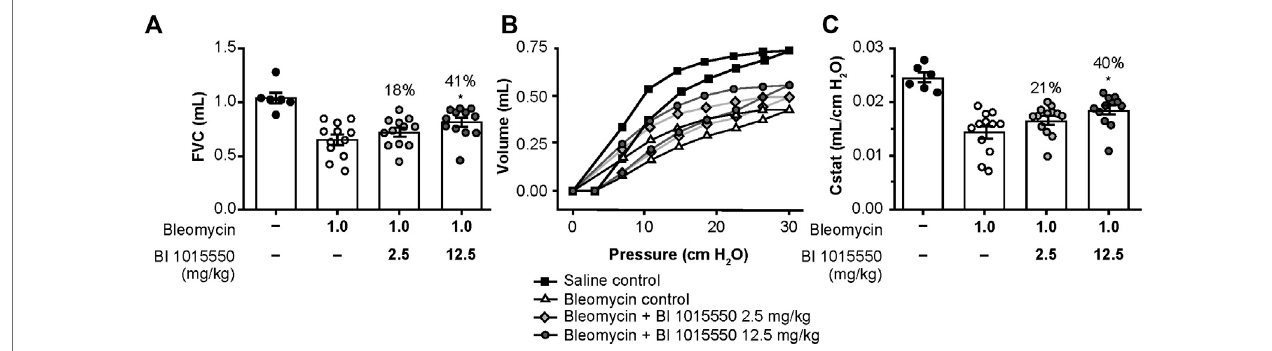
FIGURE5| EffectsoforalBI1015550(2.5and12.5 mg/kgb.i.d.)onbleomycin-challengedmiceonday14.Inhibitionof (A) FVCdecline, (B) PVloops,and (C) lung volume (Cstat) at 30 cm H 2 O. Bleomycin was administered intratracheally in an application volume of 2 mL/kg body weight. BI 1015550 (in 0.5% hydroxyethylcellulose) was administered via oral gavage in a dose volume of 10 mL/kg b.i.d., from day 8 to day 13. Data are expressed as means ± SEM. *, p < 0.05. b.i.d., twice daily; Cstat, static lung volume; FVC, forced vital capacity; PV, pressure-volume; SEM, standard error of the